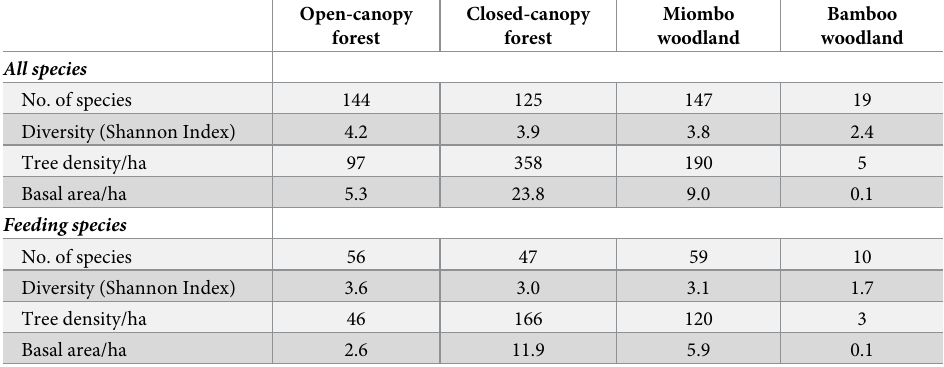
There are errors in Table 3. Multiple values in Table 3 are incorrect. Please see the correct Table 3 here. Table 3. Overview of important vegetation types found in MMNP and utilized by chimpanzees for nesting. Open-canopy Closed-canopy forest